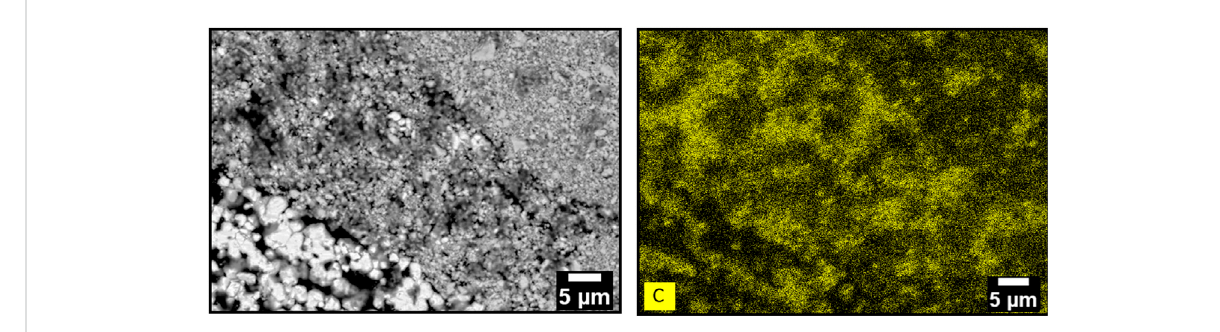
FIGURE 3 X-Ray elemental mapping analysis of a cross-section of a sorbent bead calcined at 500 ° C.